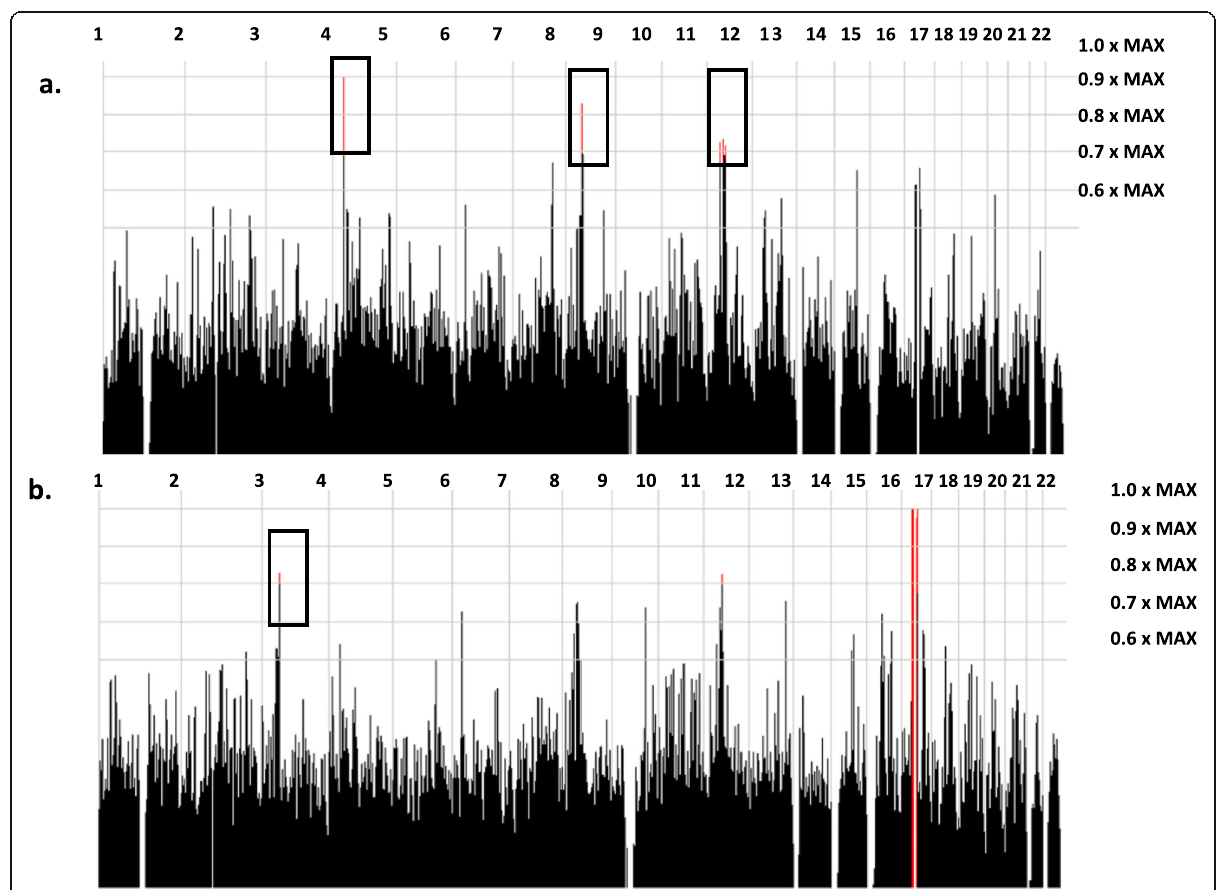
Fig. 2 Risk homozygous haplotype region peaks for autism specific enclosed in solid rectangles respectively for category